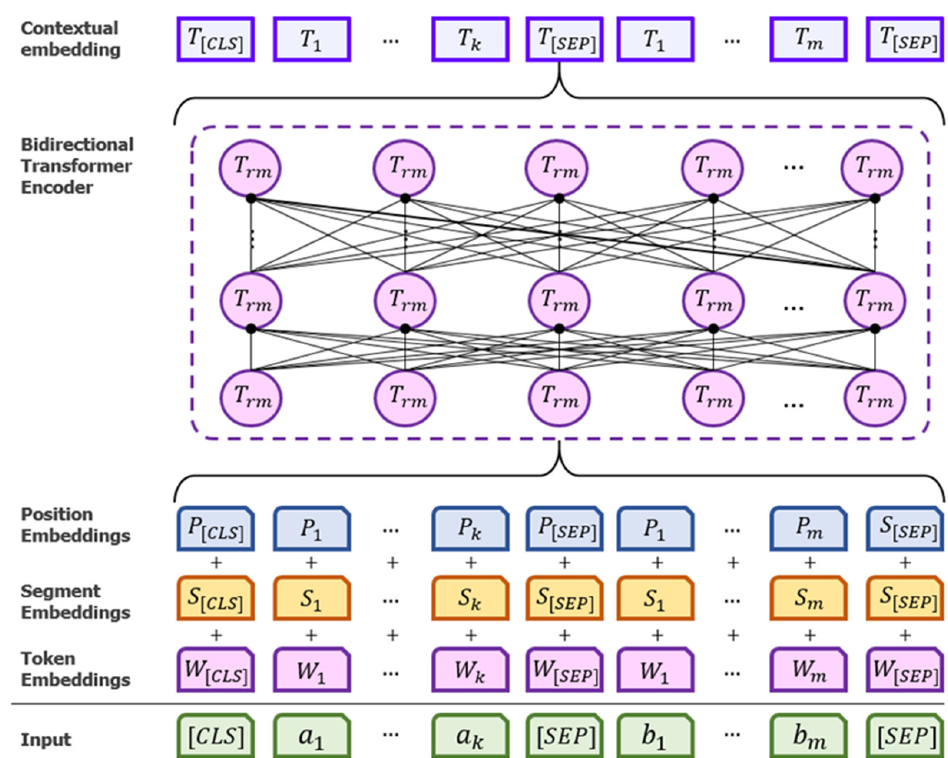
Figure 2. General architecture of BioBERT model.